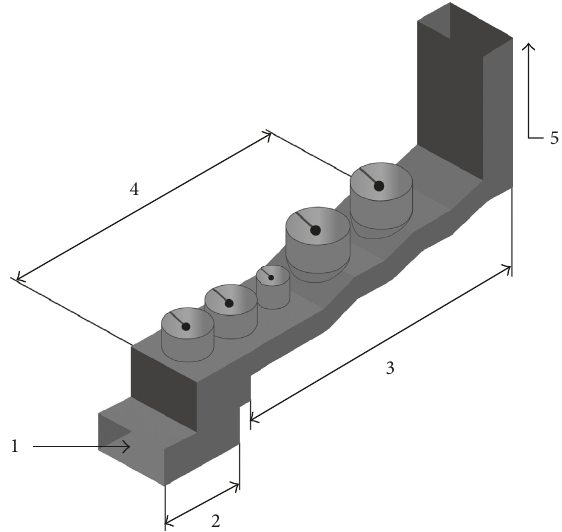
Figure 1: Traditional furnace for panela production: 1. Bagasse feed zone. 2. Combustion chamber. 3. Gas duct. 4. Heat exchangers (pans). 5.